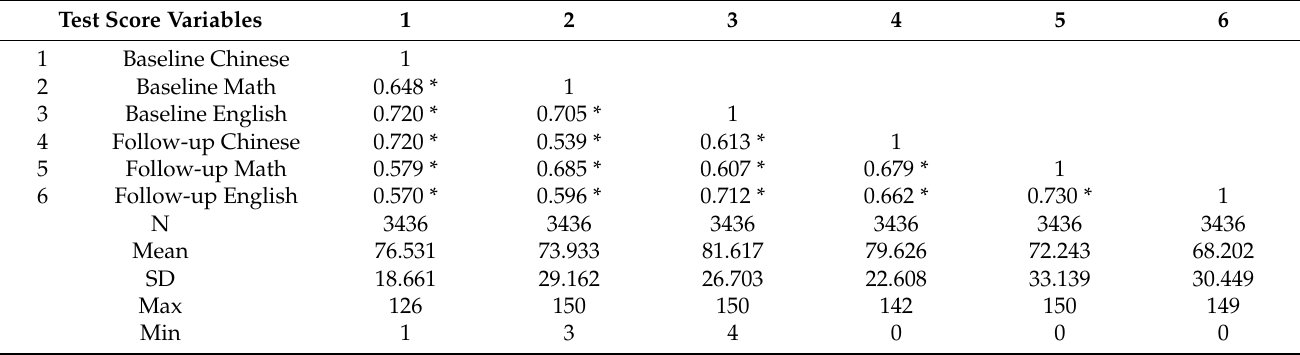
Table 1. Correlation matrix of baseline and follow-up test scores.